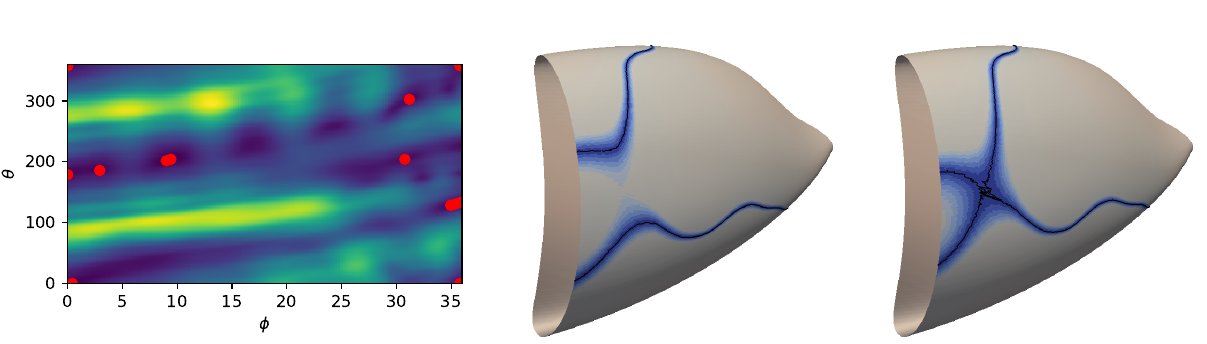
Figure 4. Left: Location of the optimal conversion regions (red dots) on the cuto ff surface ( φ and θ are toroidal and poloidal angles). The function representing the weighted gradient of the thickness of the evanescent layer is colorcoded. Middle: Conversion region for ≈ 0 . 564. Right: Optimised e ffi cient conversion region for N opt N opt ||